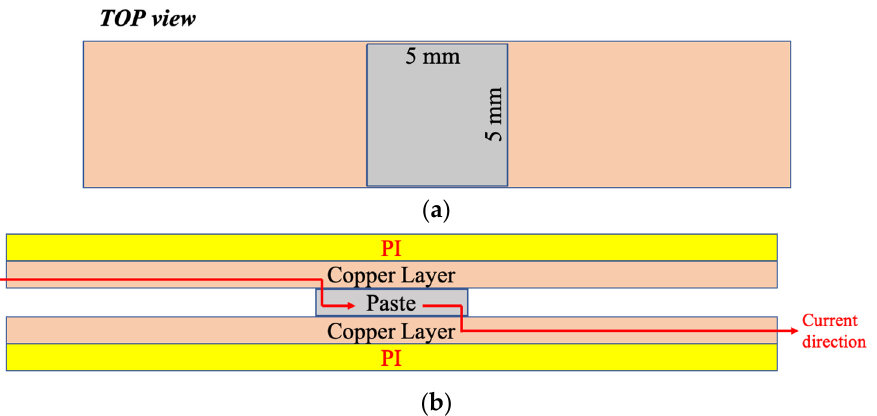
Figure 1. ( a ) Top and ( b ) side views of the two Cu-cladded PI substrates and the joint in-between, as well as the current stressing direction.